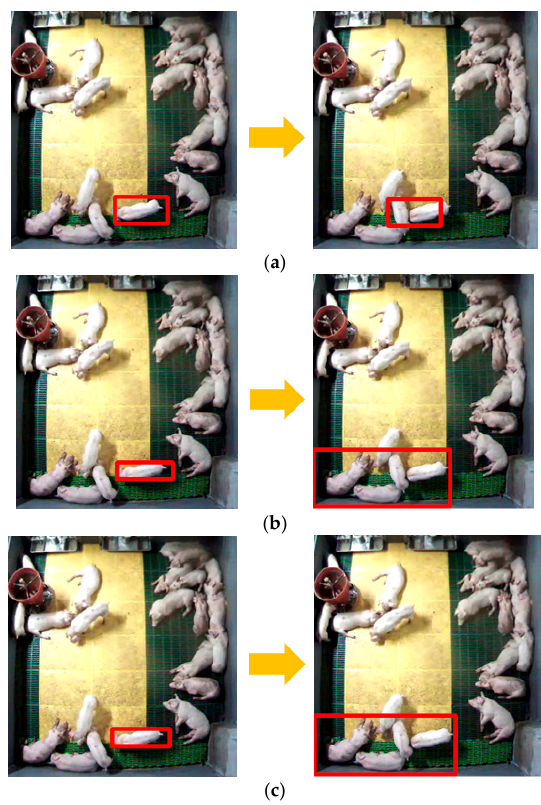
Figure 1. Tracking failures caused by touching-pigs: ( a ) results of the mean shift algorithm [24]; ( b ) results of CAM shift algorithm [25]; ( c ) results of Kalman filter algorithm [26]. Sensors 2018 , 18 , x FOR PEER REVIEW